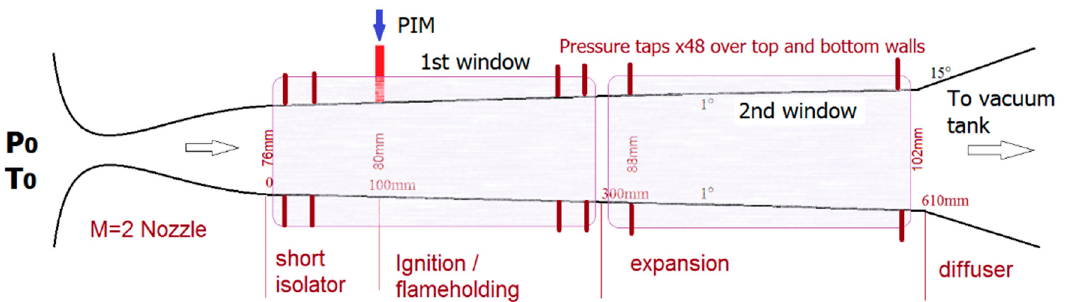
Figure 12. Geometrical configuration of the SBR-50 test section.